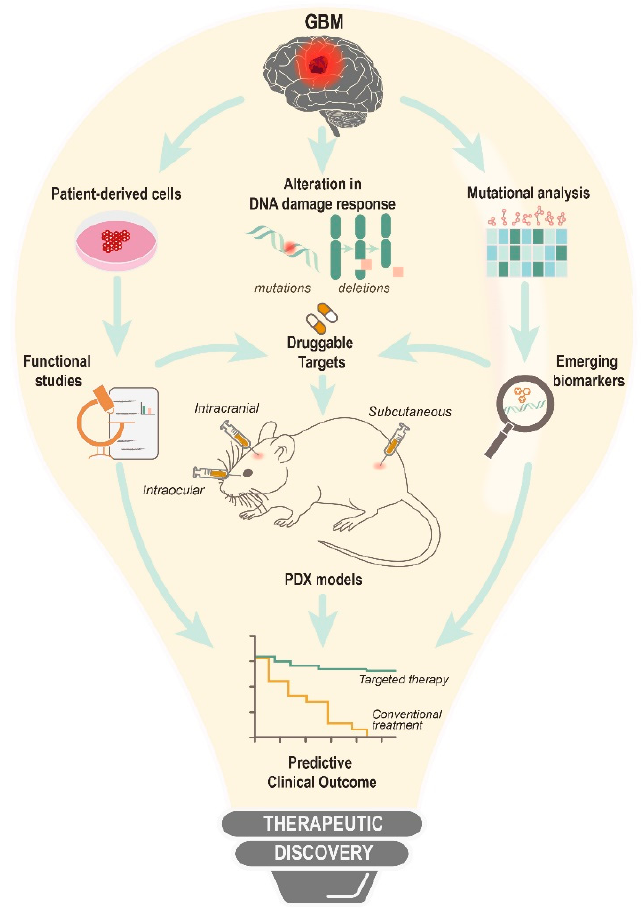
Figure 3. An overall view for the therapeutic discovery of DNA damage response and DNA repair inhibitors.